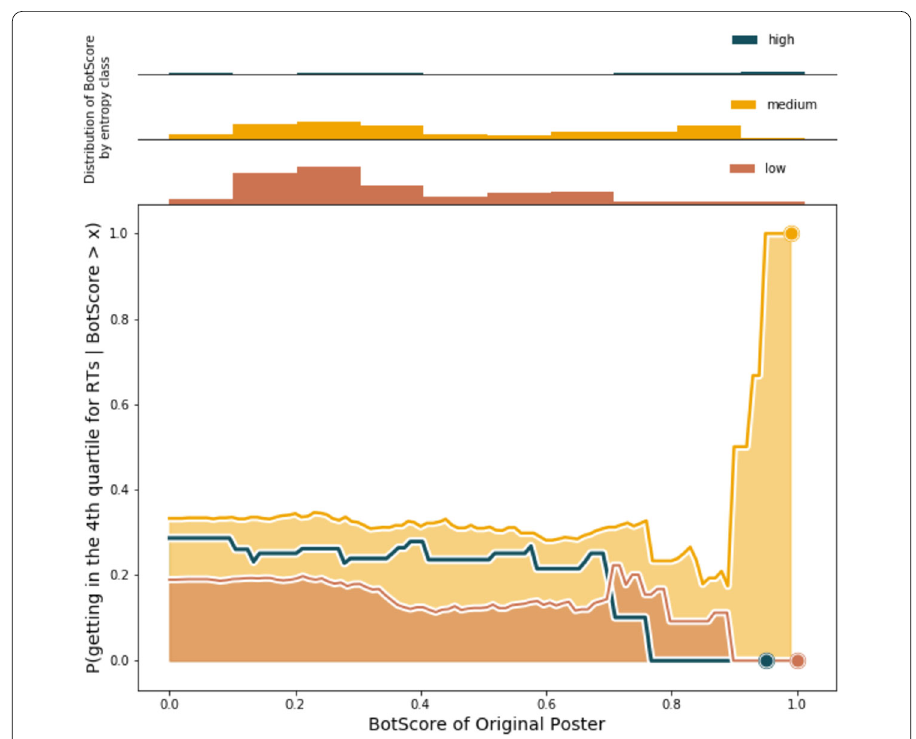
Figure 6 Probability of success for a URL given the BotScore of the OP. Medium entropy URLs tend, in general, to be more successful than the others, regardless of the BotScore of the